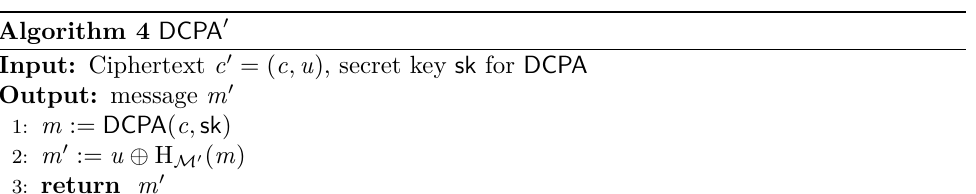
Algorithm 4 DCPA